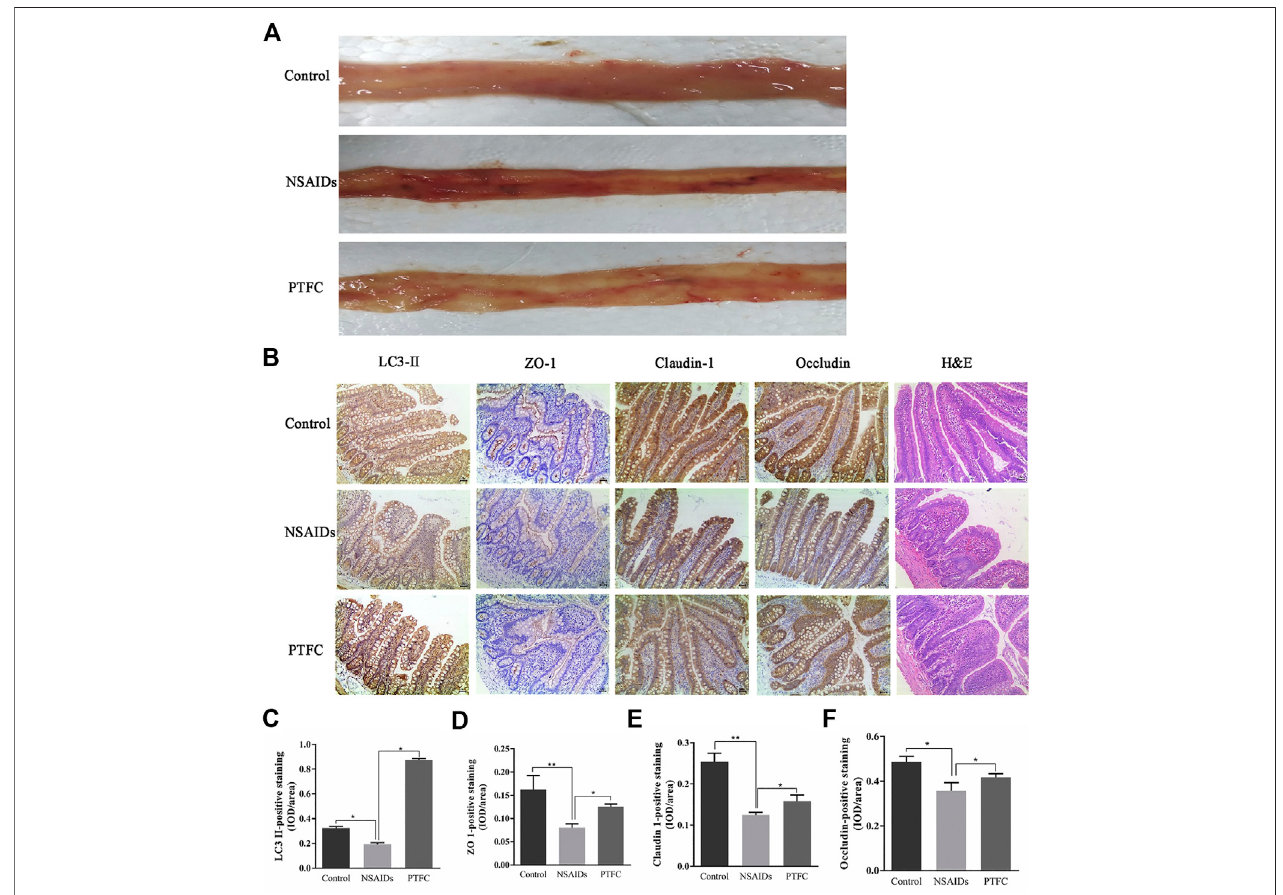
FIGURE 3 | Morphological examination of various experimental groups or rats (A) Morphological changes in the intestinal mucous membrane were observed (B) Hematoxylin and eosin (H&E) staining revealed severe injuries in the small intestines of rats in NSAID model group, whereas the PTFC group showed signi fi cant